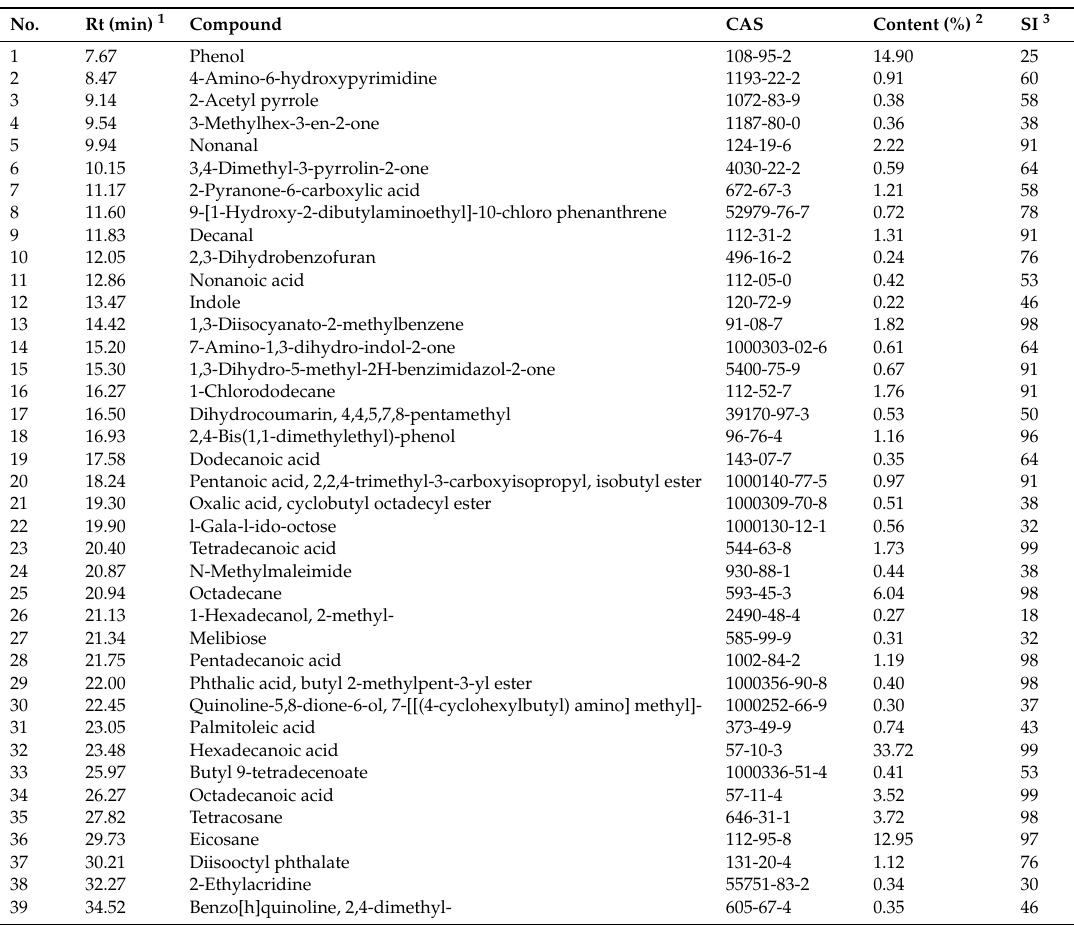
Table 1. GC-MS analysis of TBs-10-30k pyrolytic products at 280 ◦